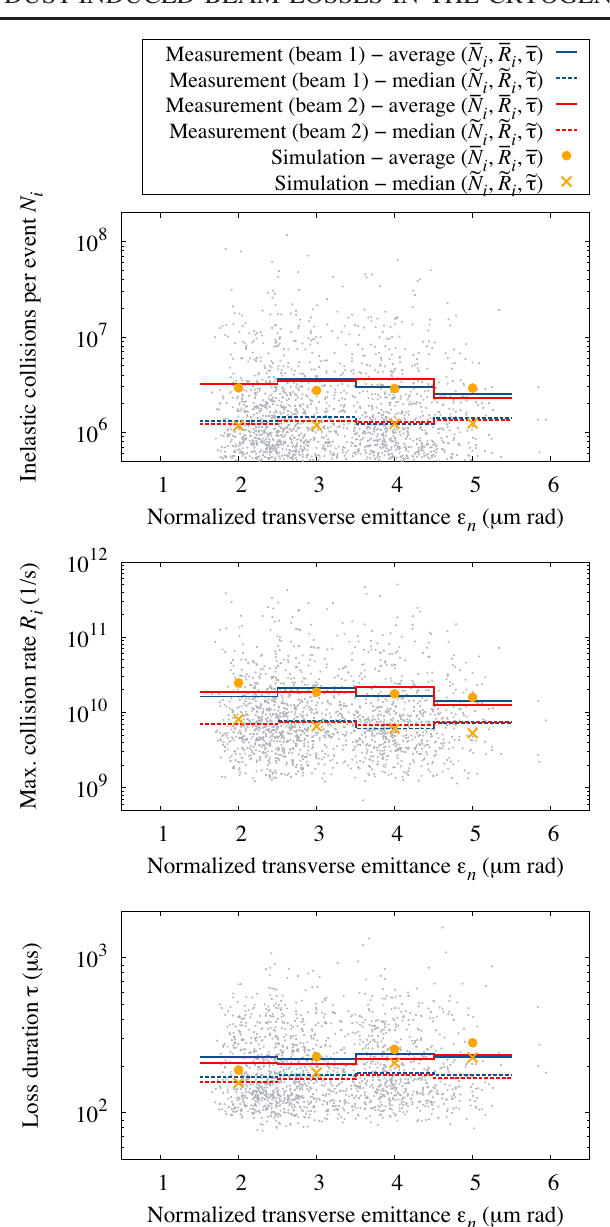
FIG. 12. Number of inelastic proton-nucleus collisions (top), maximum collision rate (center) and loss duration (bottom) of dust particle events as a function of the normalized transverse beam emittance. The measurements are a subset of the data shown in Fig. 11. The average and median values of the measurements are indicated by the solid and dashed lines, respectively (beam 1 in blue and beam 2 in red). Only events from 2016 – 2018 at beam intensities I ≥ 1 . 5 × 10 14 protons were considered. Simulations (yellow symbols) were performed for discrete emittance values only (average values are given by circles, median values are given by